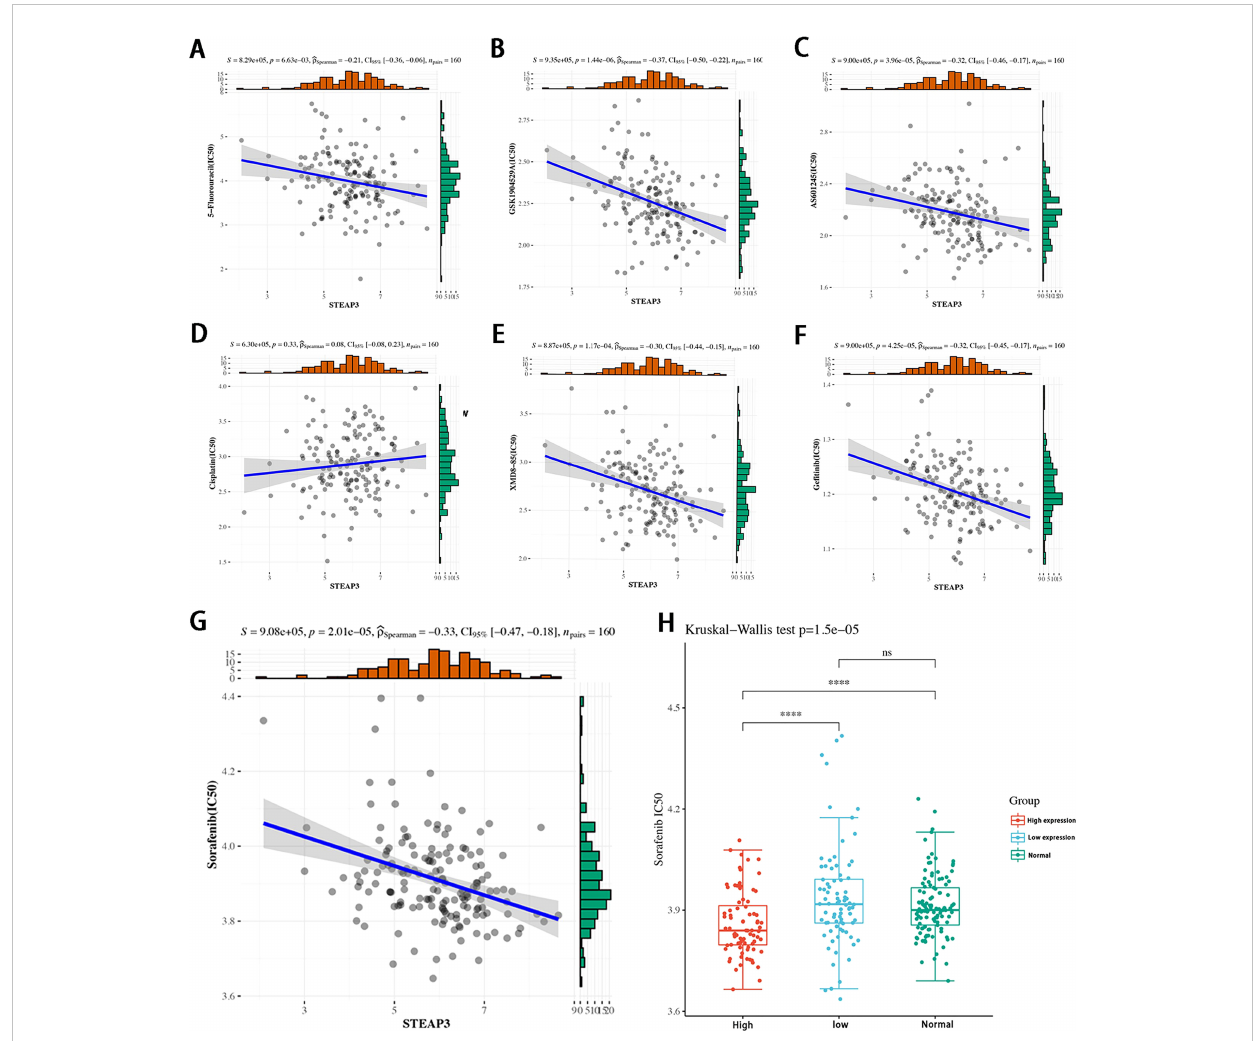
FIGURE 9 Correlations between STEAP3 expression and drug sensitivity in patients with TNBC. (A-F) The expression of STEAP3 and IC50 values correspond to 5 − Fluorouracil, GSK1904529A, AS601245, XMD8 − 85, and Ge fi tinib in TNBC patients included in the TCGA-TNBC cohort (P<0.05). (G, H) Correlations between STEAP3 expression and Sorafenib IC50 values with further details regarding expression in the low, high, and normal groups (P<0.01). (****P< 0.0001, ns